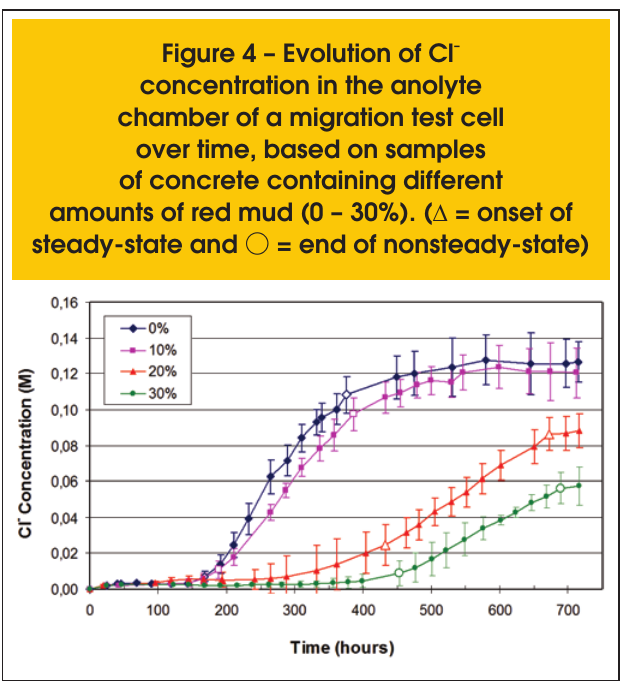
Figure 5 – Experimental determination of the time lag ( t ); onset ( ∆ ) and end ( ○ ) of the steady-state diffusion stage, with a diffusion coefficient of D